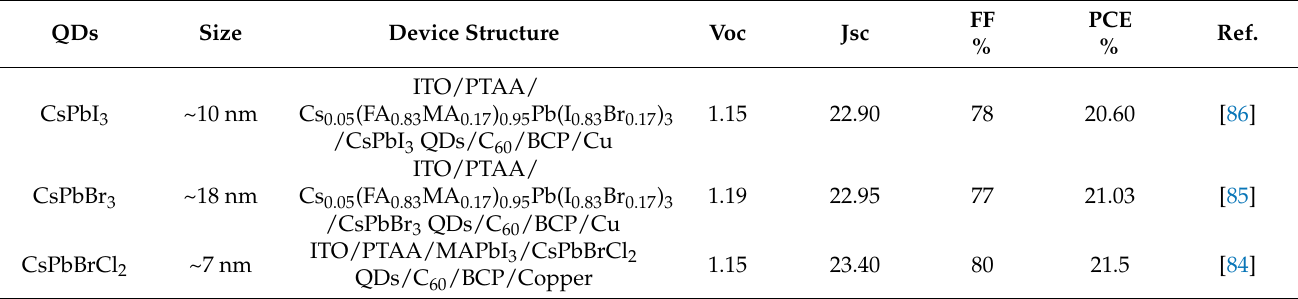
Table 2. Details of PQDs as the perovskite/ETL interface